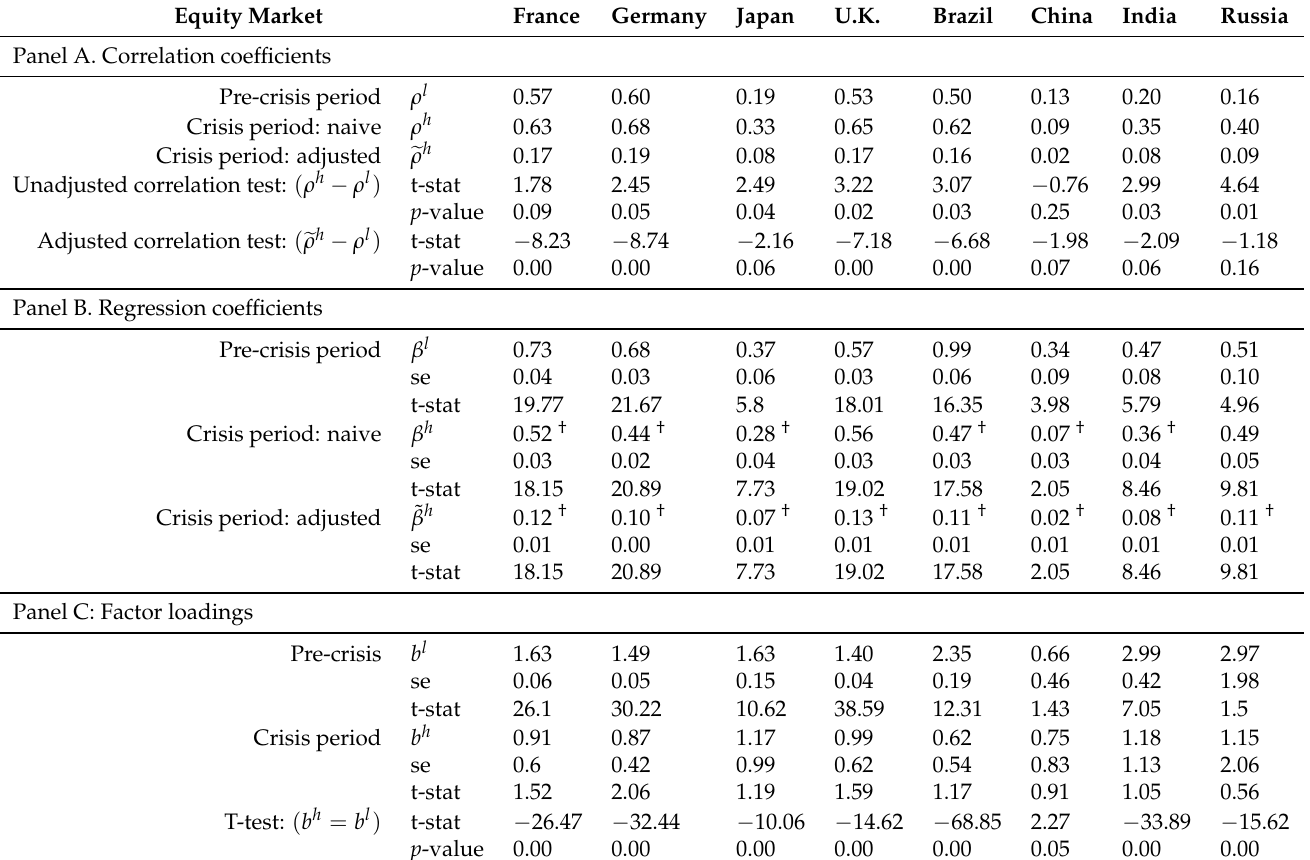
Table 4. Tests for contagion in financial sectors of sample